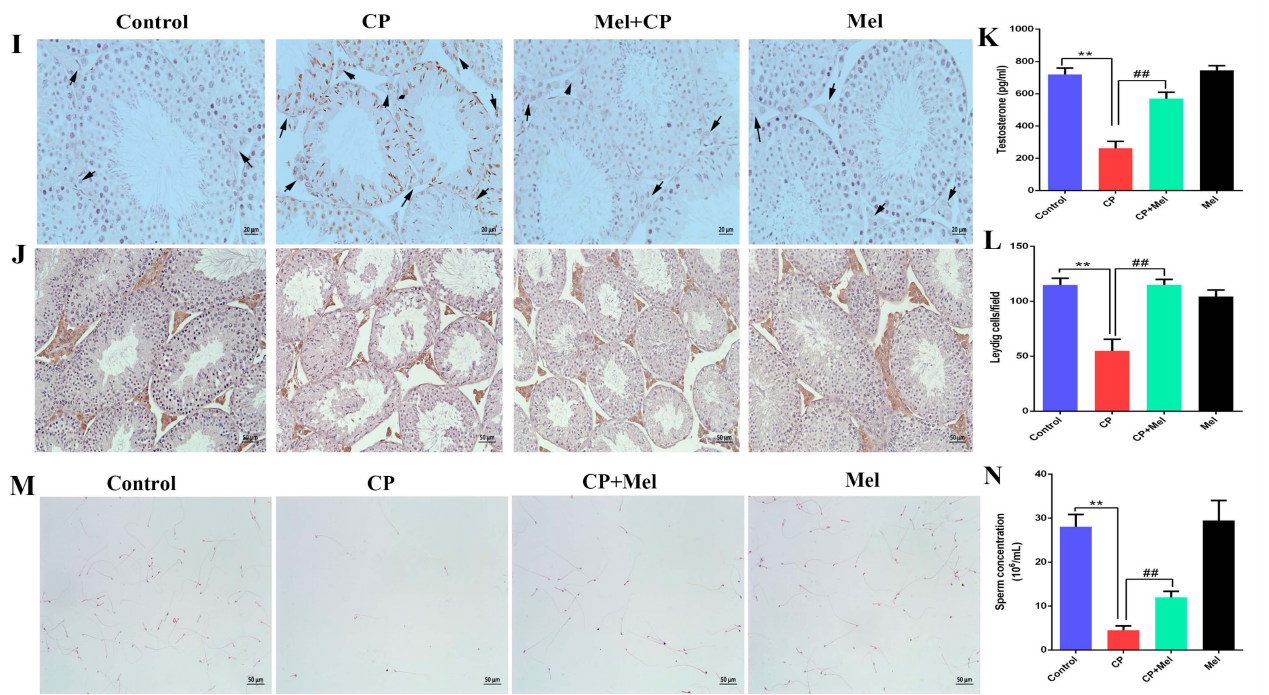
Figure 5. Melatonin can alleviate damage to mouse testes and Leydig cells induced by cisplatin. ( A ) Experimental design. ( B ) Changes in the body weight of mice. ( C ) Images of mouse testes sizes. ( D ) Images of mouse epididymides sizes. ( E ) Mouse epididymides stained with H&E (scale bar = 50 µ m). ( F ) Mouse testicular cross sections stained with H&E (scale bar = 50 µ m). ( G ) Testicular cross sections stained with TUNEL to show apoptosis (scale bar = 50 µ m). ( H ) 3 β -HSD staining was used to immunolocalize Leydig cells. ( I ) Number of Leydig cells. ( J ) H&E-stained mouse sperm (scale bar = 50 µ m). ( K ) Mouse testicular weights. ( L ) Mouse epididymides weights. ( M ) Testosterone level in mouse testes. ( N ) Epididymal sperm cells were counted. CP, cis- platin. CP + Mel, cisplatin + melatonin. Mel, melatonin. Data are presented as the mean ± SEM. ( N = 8 per group). * p < 0.05, ** p < 0.01 compared with controls. # p < 0.05, ## p < 0.01 compared with the CP